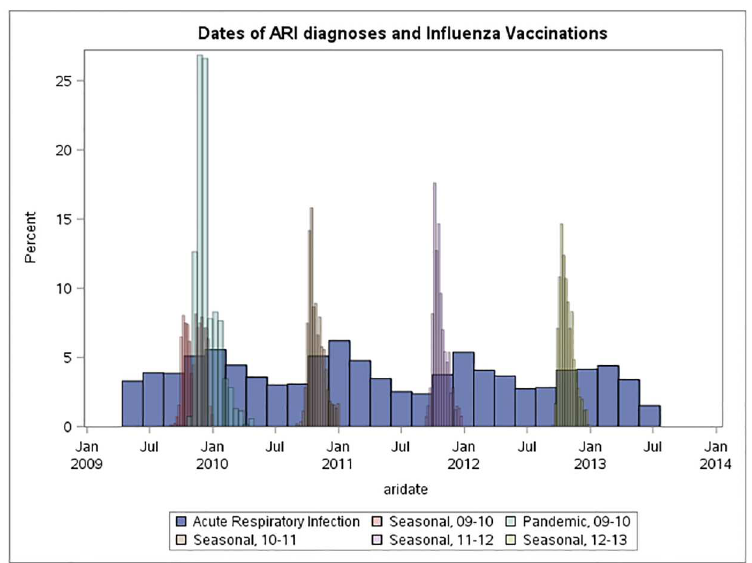
Fig 1. Distribution of Bell’s palsy diagnosis dates and dates of vaccination during the observation period.